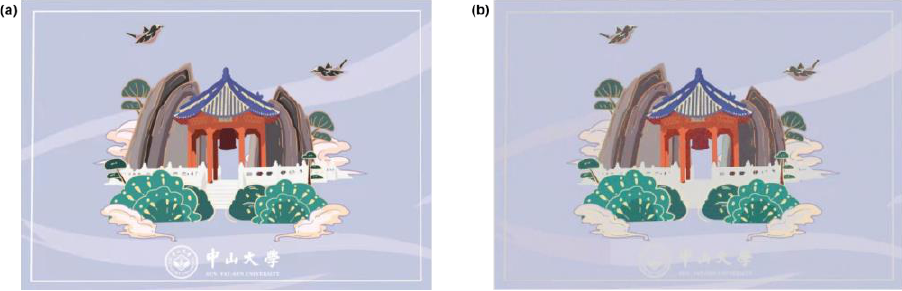
Figure 6. ( a ) The desired colors of the painting “Sun Yat -sen university- Xing Pavilion”. ( b ) The inverse-designed structural colors by ANN.